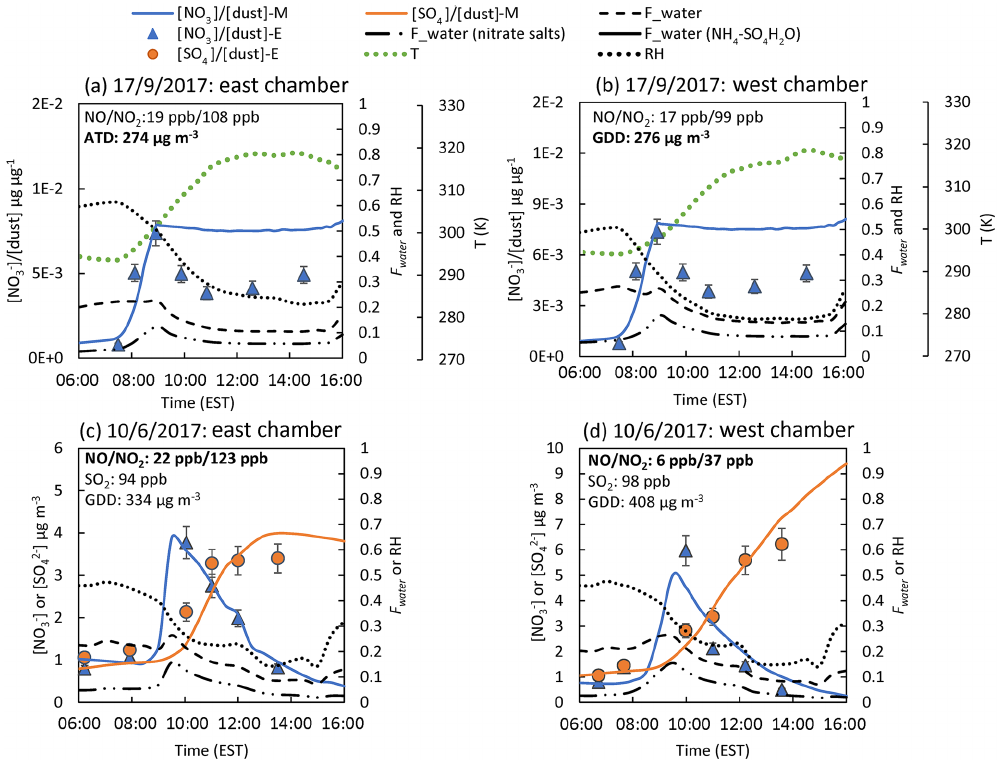
Figure 4. Simulation of the outdoor chamber data using the AMAR model for (a) ATD (17 September 2017) and (b) GDD (17 Septem- ber 2017) particles in the presence of NO x and SO 2 oxidation on GDD particles in the presence of (c) high NO x (10 June 2017) and (d) low NO x (10 June 2017) concentrations. F water (nitrate salts) and F water (NH + represent the additional absorbed water by alkaline nitrate salts and the ammonium sulfate system, respectively. The simulation result was not correct for particle